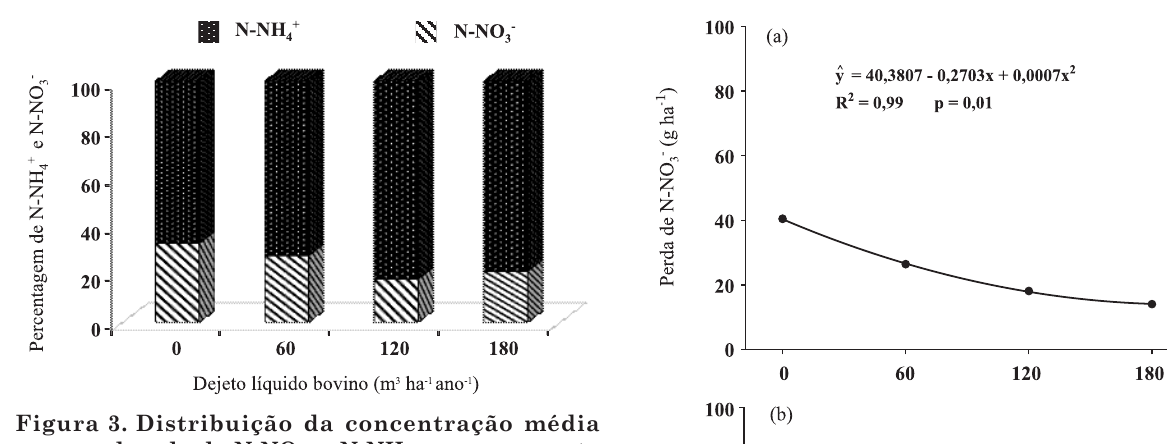
Figura 3. Distribuição da concentração média ponderada de N-NO 3- e N-NH em escoamento 4 superficial sob chuva natural após a aplicação de doses de dejeto líquido bovino em Latossolo franco-argiloarenoso manejado sob plantio direto. Ponta Grossa-PR. Avaliações de novembro de 2005 a maio de 2008.